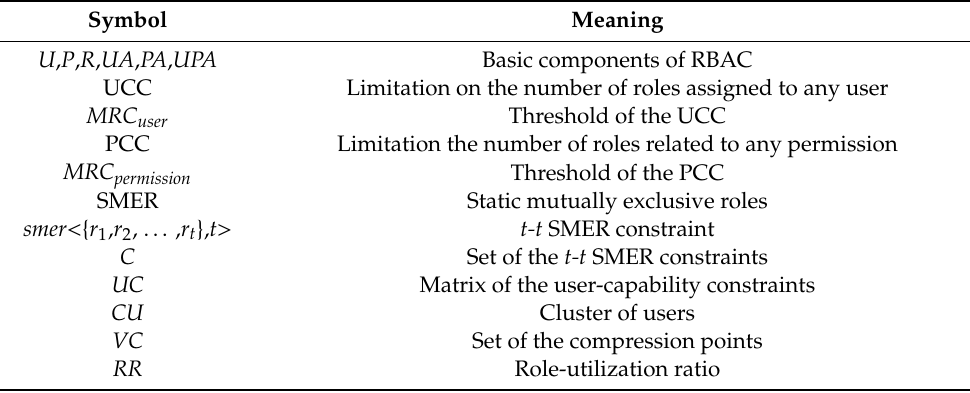
Table 1. Main symbols and their meanings.